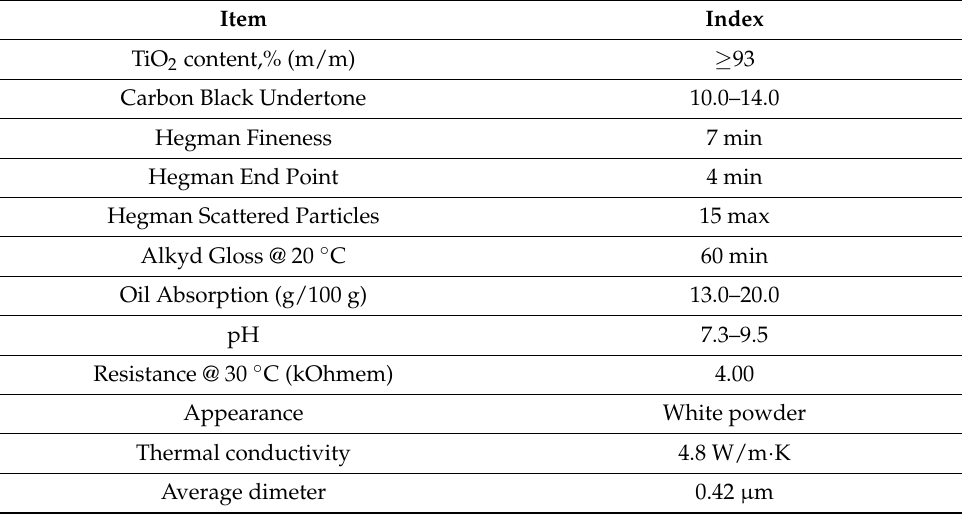
Table A2. Thermal properties of titanium dioxide R-902+.